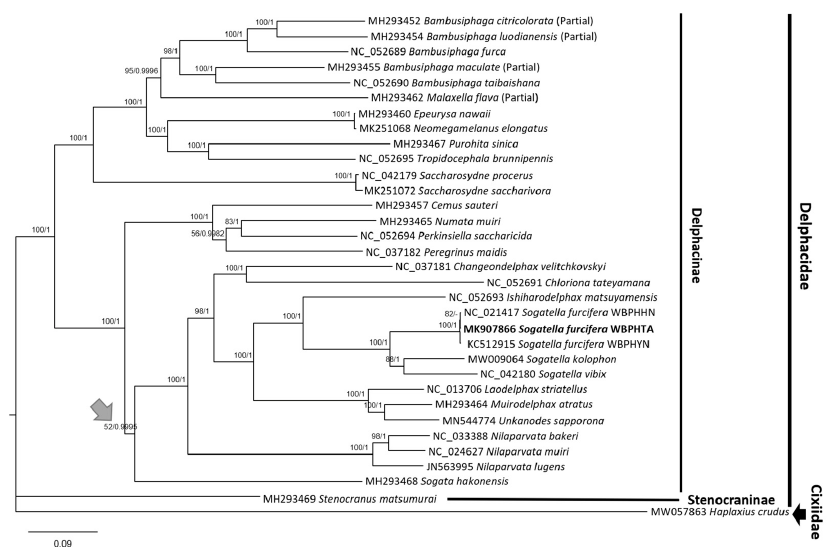
Figure 7. Phylogenetic tree of 32 Delphacidae mitogenomes. Phylogenetic trees constructed by Maximum-Likelihood (ML) and Bayesian inference (BI) methods were presented with supportive values of ML and BI, respectively, on the branches. Accession names and species names were printed on the right side of the phylogenetic tree. Subfamily names were shown with the thick bars at the right side of the tree.